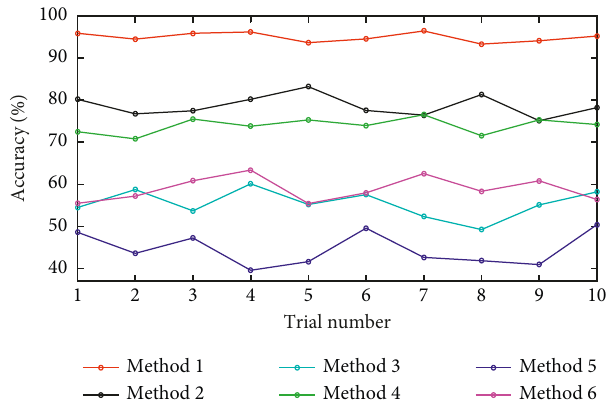
Figure 10: Diagnosis results of the 10 trials.